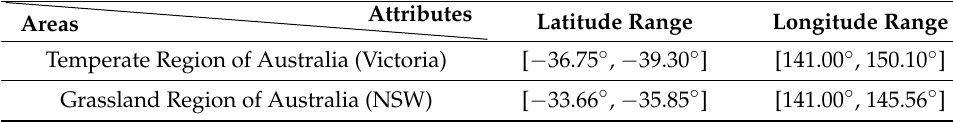
Table 1. Statistics of two climate zones used for our experiments.